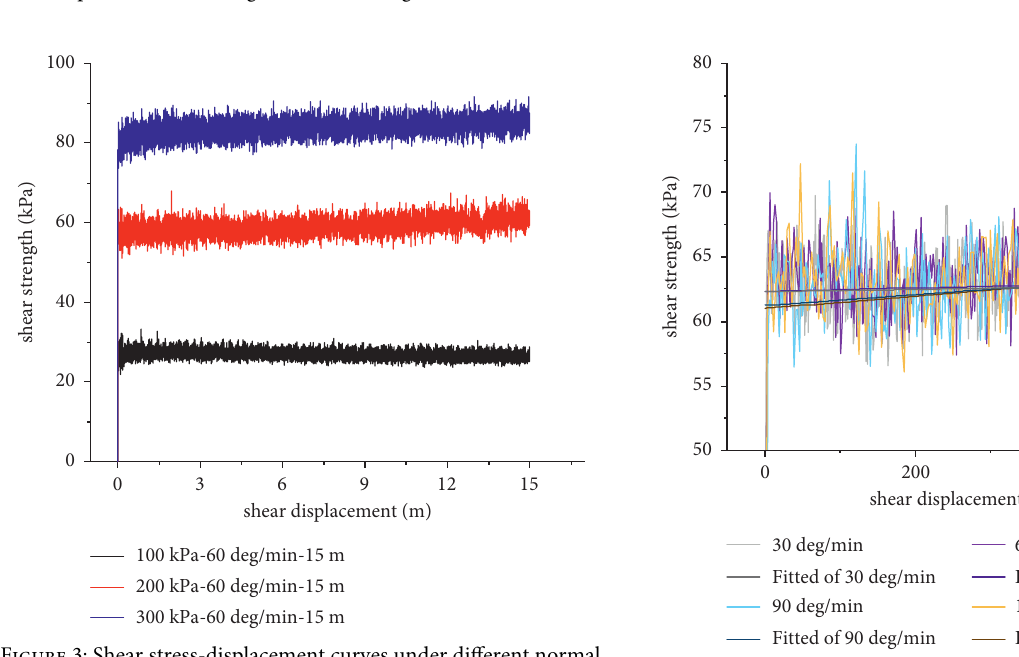
Figure 4: Shear stress-displacement curves at different shear